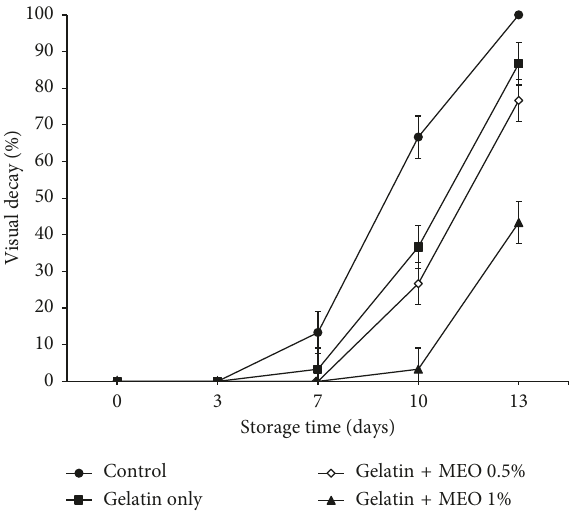
Figure 4: Visual decay of coated and uncoated strawberries during storage at 4 ° C for 13 days. Vertical bars represent the standard deviation ( n �